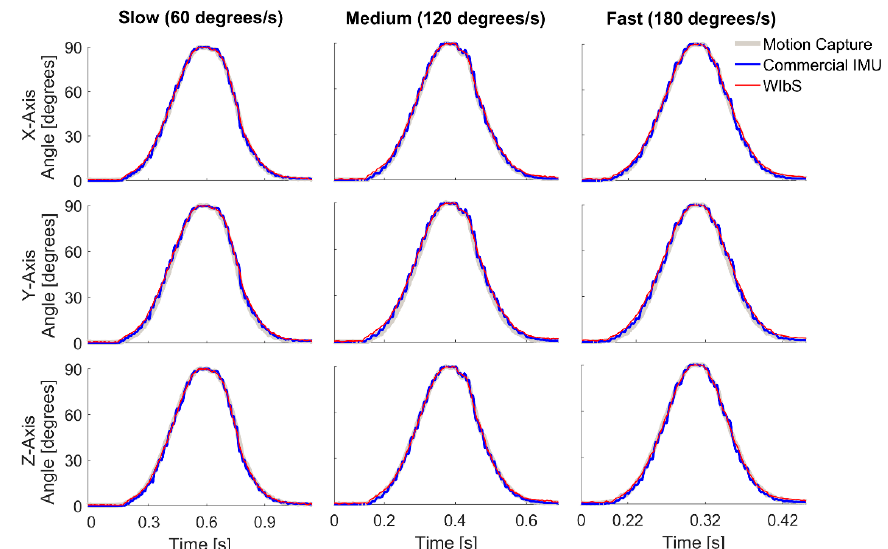
Figure 3. The Gaussian profile results for the individual axes of the wireless inertial measurement unit-based system (WIbS), red lines, when compared to those of the commercial inertial measurement unit system (cIMU), blue lines, and the motion capture system, gray lines. The rows show results for individual axes, whereas the columns represent the tested velocities.